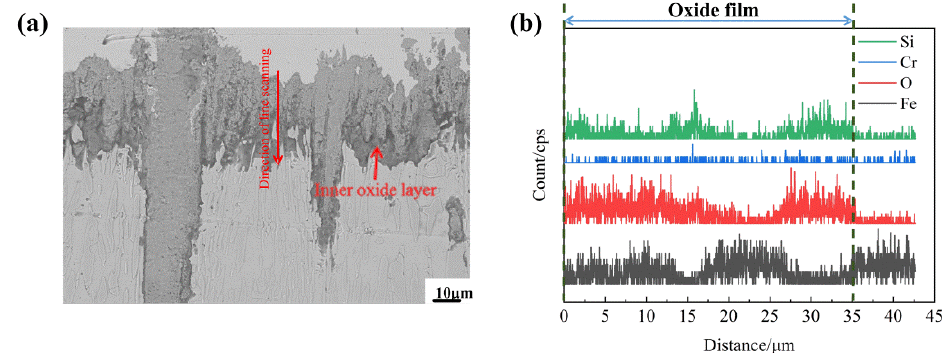
Figure 12. Line scanning analysis of a cross-section of the Fe 2 B // A4 sample oxidized for 60 h at 1073 K: ( a ) diagram of line scan, ( b ) curve change diagram of each element of the line scan.